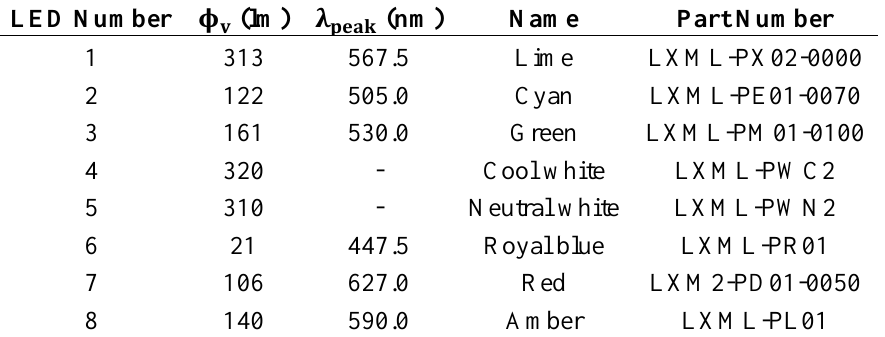
Table 2. The luminous flux ϕ values were provided by the manufacturer (Phillips Lumileds, San Jose, CA, USA).